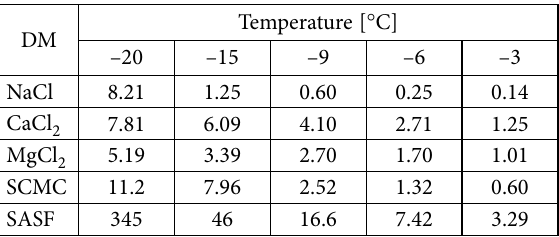
Table 5. Price of one percent of melted ice, when it is